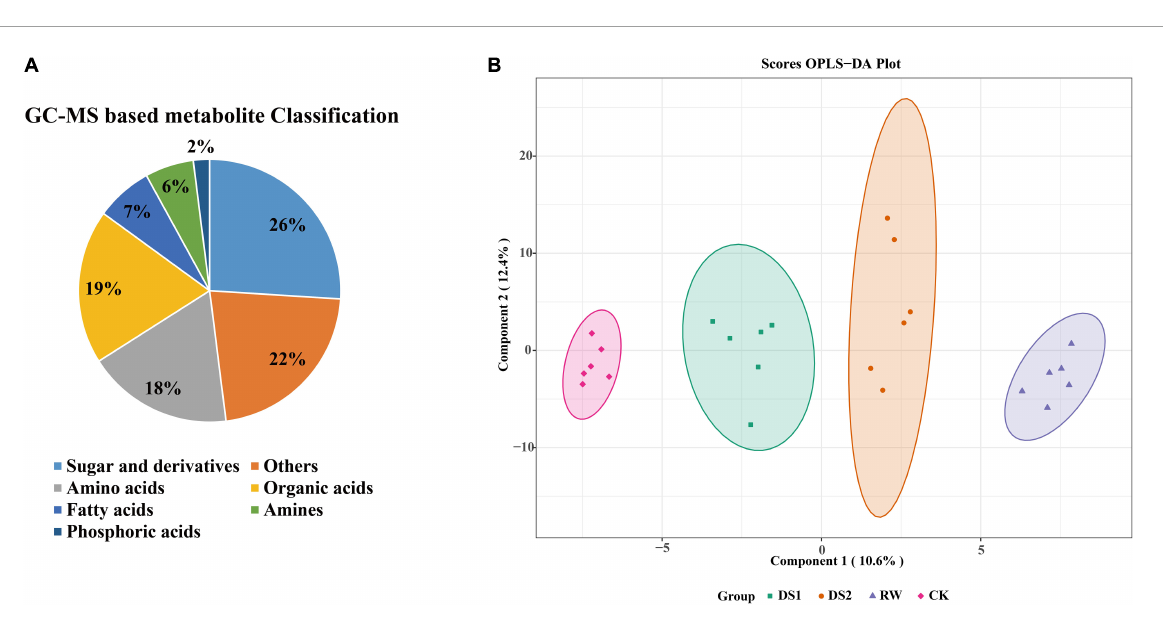
lacking in most samples, a total of 78 metabolites were chosen and their concentrations were determined for further